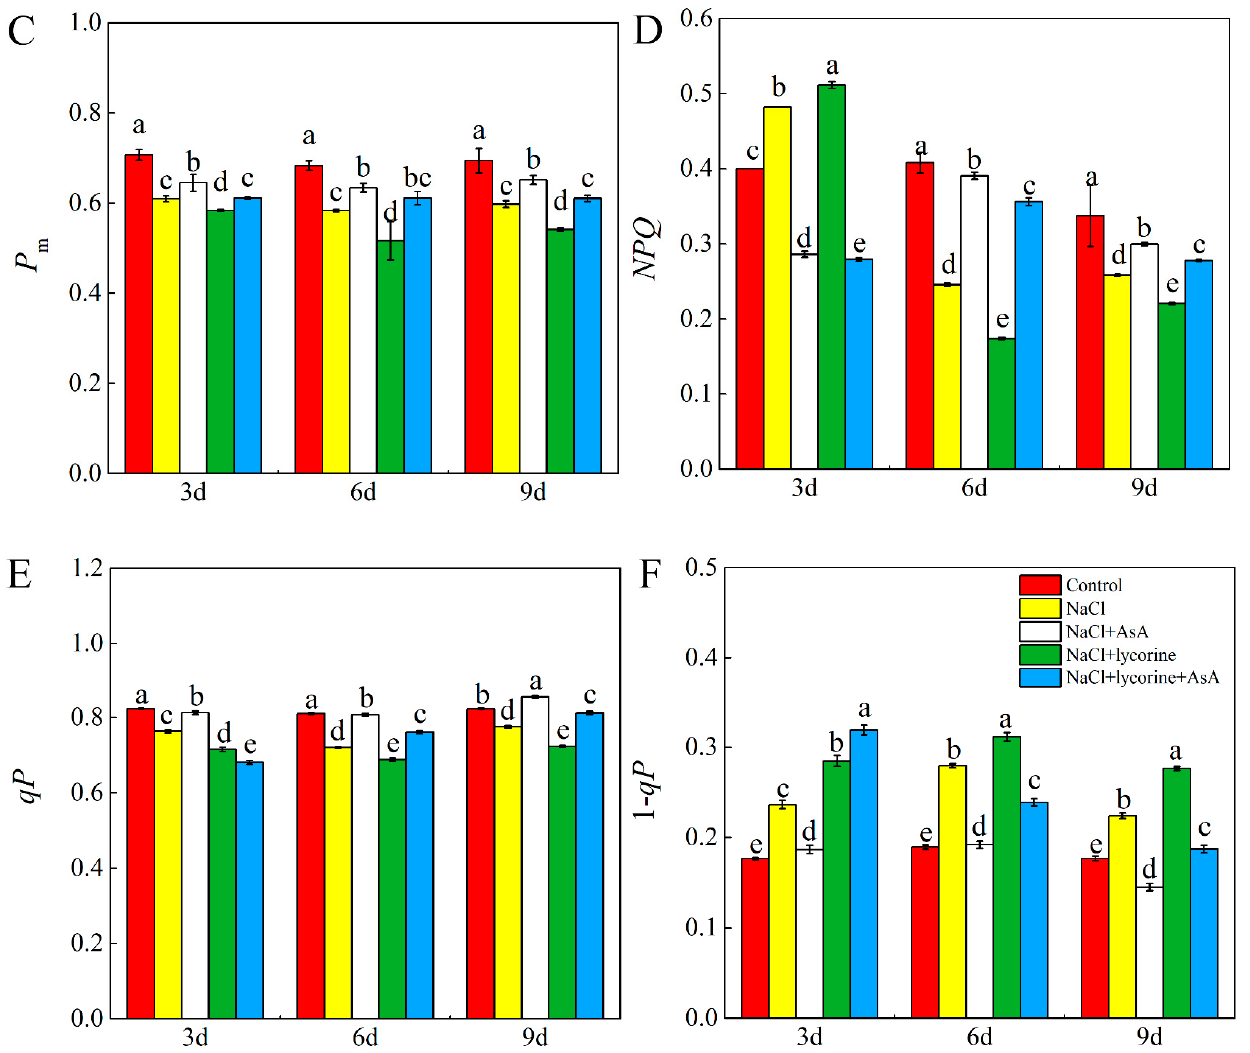
Figure 1. Values of the maximal photochemical efficiency of PSII ( F v / F m ) ( A ), false-color images of F v / F m ( B ), maximal P700 changes ( P m ) ( C ), non-photochemical quenching coefficient ( NPQ ) ( D ), photochemical quenching coefficient ( qP ) ( E ), and PSII excitation pressure (1– qP ) ( F ) in leaves of salt-stressed tomato seedlings with or without exogenous reduced ascorbic acid (AsA) and lycorine (AsA synthesis inhibitor) spraying. Abbreviations 3d, 6d, and 9d represent the third, sixth, and ninth day after treatment, respectively. Control, no added NaCl and sprayed with distilled water; NaCl, added 100 mmol · L –1 NaCl and sprayed with distilled water; NaCl + AsA, added 100 mmol · L –1 NaCl and sprayed with 0.5 mmol · L –1 AsA; NaCl + lycorine, added 100 mmol · L –1 NaCl and sprayed with 0.25 mmol · L –1 lycorine; NaCl + lycorine + AsA, added 100 mmol · L –1 NaCl and sprayed with 0.25 mmol · L –1 lycorine plus 0.5 mmol · L –1 AsA. Values are means ± SD ( n = 3). Values with a different letter within a sampling date are significantly different ( p < 0.05).